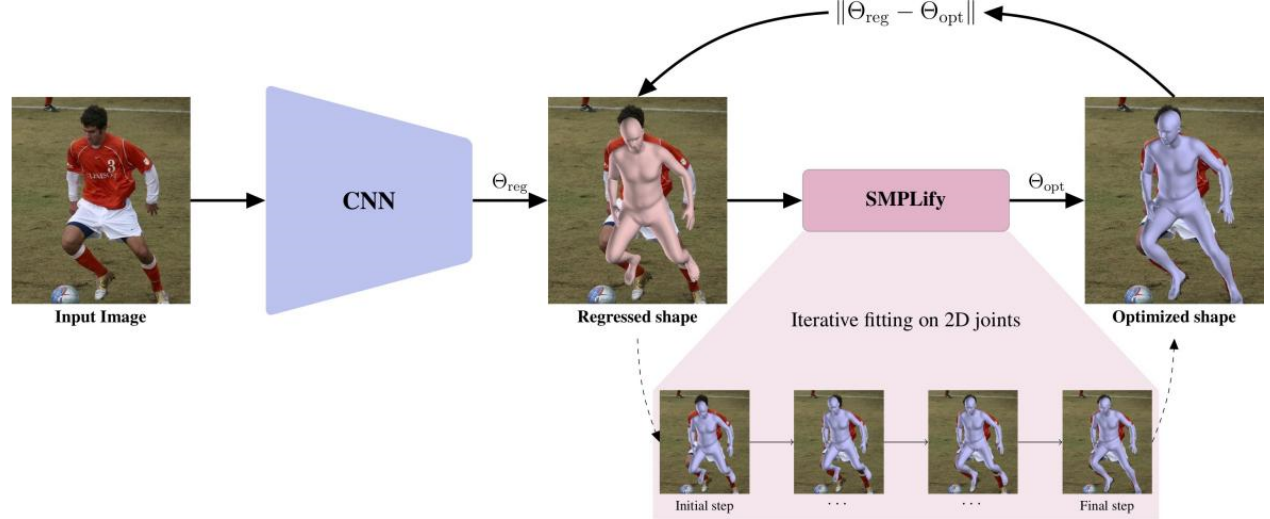
Figure 6. A hybrid approach of regression-based and optimization-based paradigms (courtesy of Kolotouros et al. [116]): an iterative optimization routine is embedded into a neural network training loop, leading to a self-improving loop. Better fits help the network train better, while better initial estimates from the network help the optimization routine converge to better fits.